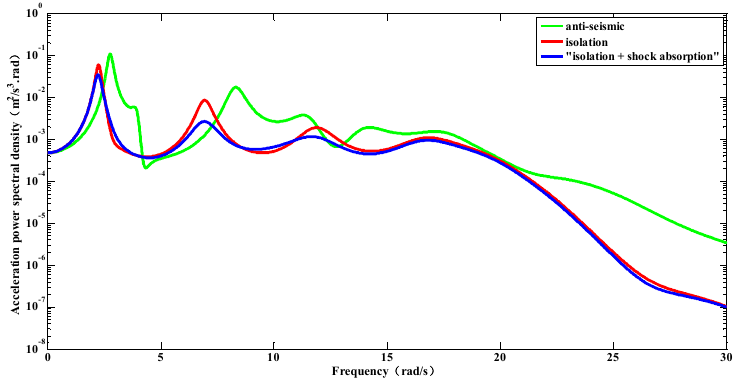
( b ) Figure 18. Energy distribution map of layer position under different control schemes: ( a ) a three- dimensional view from one angle; ( b ) a three-dimensional view from another angle . There is more energy distribution in the middle of the tower, and less energy distri- bution in the top of the large chassis podium and the tower. The adoption of the CPC method can reduce the energy of each layer as a whole, and effectively reduce the problem of amplification of the isolation layer response caused by the isolation scheme. When the connection control device is arranged on the top of the tower, the control effect is best. Therefore, the optimal layout scheme is obtained. That is, the optimal damping of the connecting control device is 6.7223 × 10 6 N·s/m, the optimized stiffness is 0 N/m. The con- necting control device is arranged on the 16th layer of the tower. Figure 19. shows the acceleration power spectral density of the top layer of the corresponding anti-seismic structure, isolation structure and ‘isolation + shock absorption’ structure with the Clough– Penzien spectrum as input. Compared with the anti-seismic structure, the isolation struc- ture and the ‘isolation + shock absorption’ structure show obvious damping effect. At the same time, compared with the isolation structure, the ‘isolation + shock absorption’ struc-